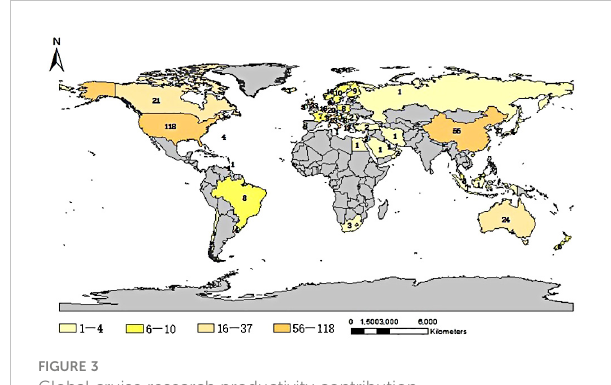
FIGURE 3 Global cruise research productivity